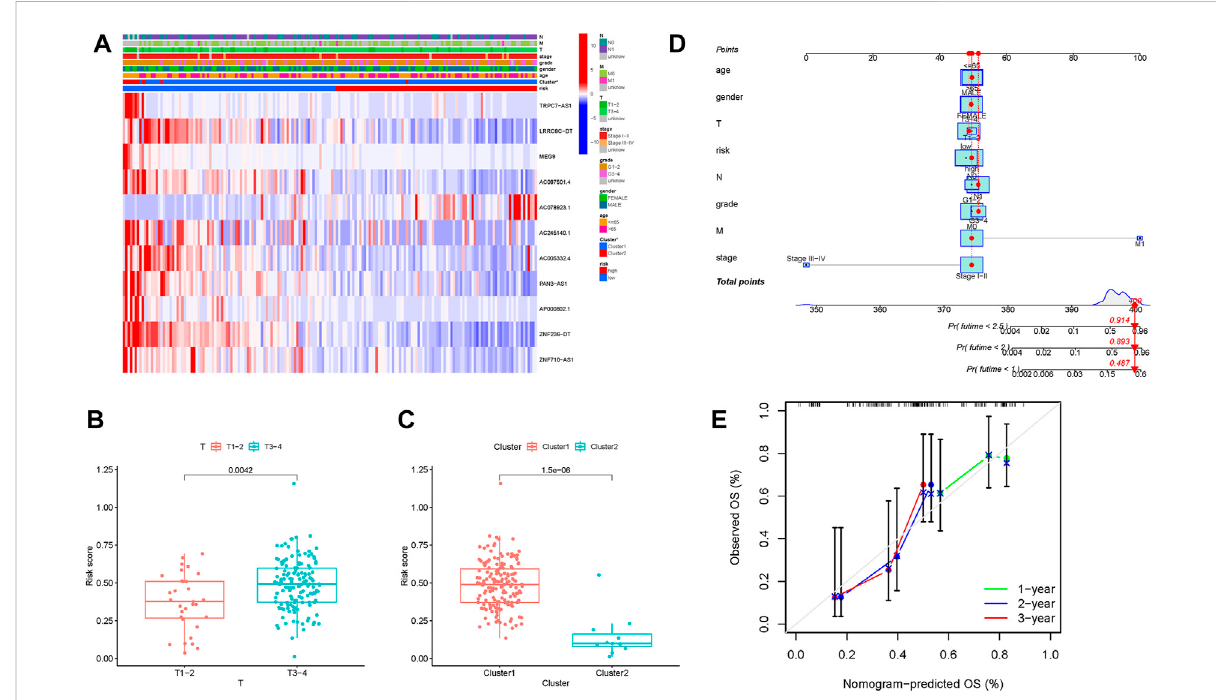
FIGURE 8 Correlation analysis of the risk score with clinical factors, m6A clusters. (A) Heatmap of m6A-related lncRNAs together with clinical factors and m6A clusters. Blue represents downregulated expression, and red represents upregulated expression. (B) Difference in the risk score between T1-2 and T3-4 subgroups. (C) Difference in the risk score between m6A Cluster 1 and m6A Cluster 2. (D) Nomogram was assembled by clinical traits and risk signatures for predicting the survival of PDAC patients. (E) Nomogram calibration curves for 1-, 2-, and 3-year overall survival